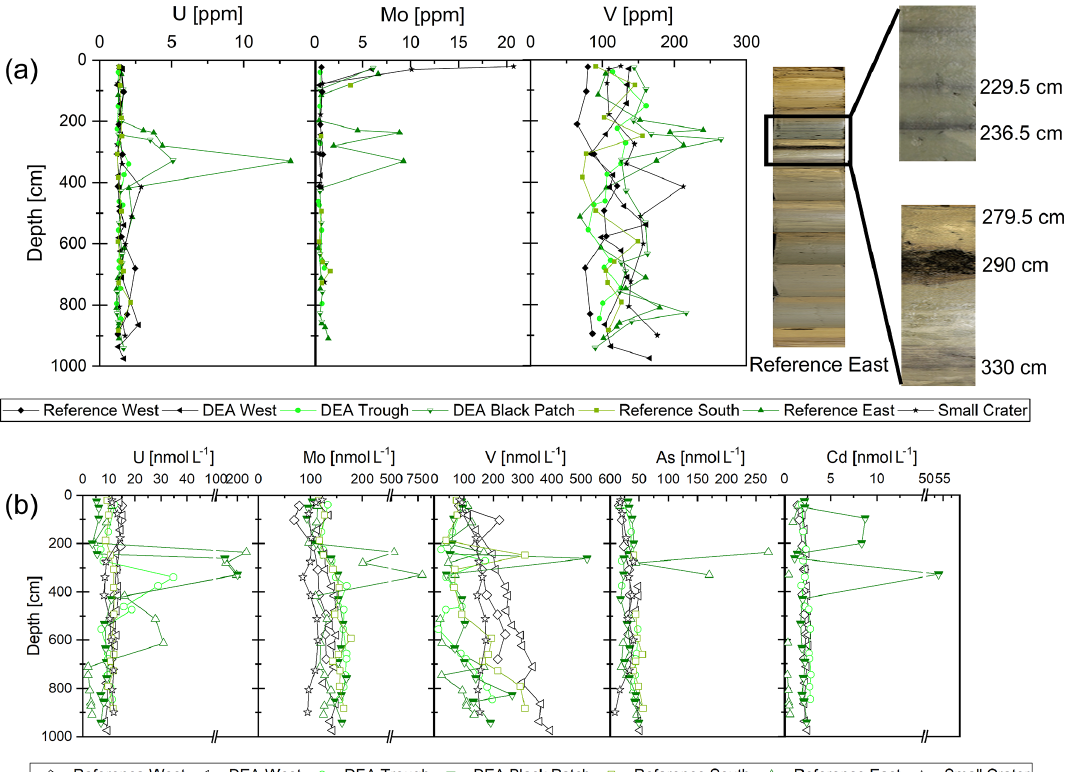
Figure 8. (a) Solid-phase concentrations of U, Mo, and V. Concentration peaks are visible at 229.5, 236.5, and 330cm for Reference East, coinciding with the gray bands in the sediment (see pictures on the right). In this core, a dissolving nodule was also found at 290cm (see pictures on the right). (b) Dissolved concentrations of U, Mo, V, As, and Cd in the porewater. Depths of 229.5 and 290cm at Reference East were not measured. Concentration peaks are visible at 236.5 and 330cm for Reference East, coinciding with the gray bands in the sediment (see pictures on the